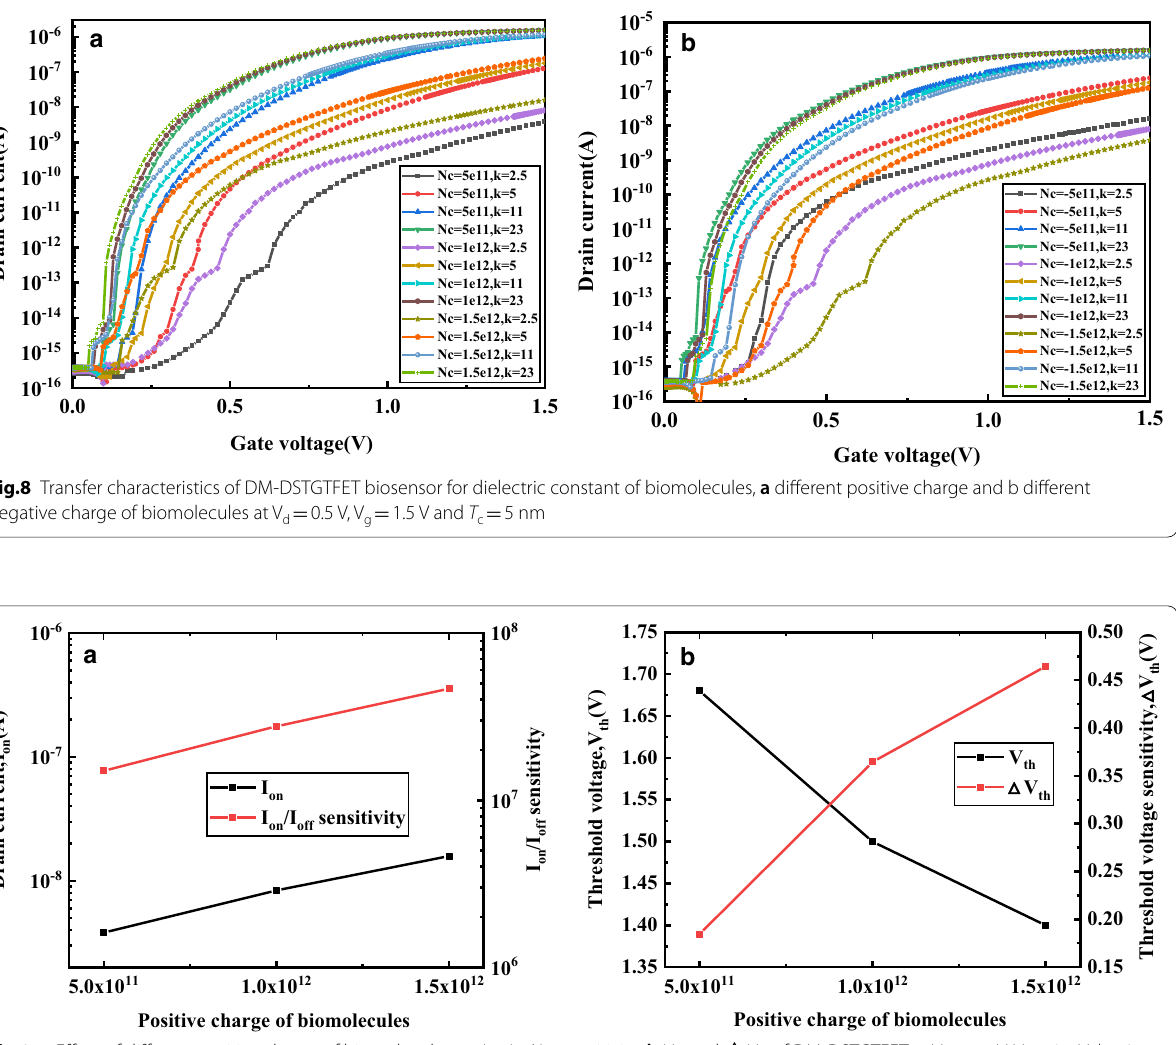
1.5 V, V d 0.5 V, k 2.5 = = =